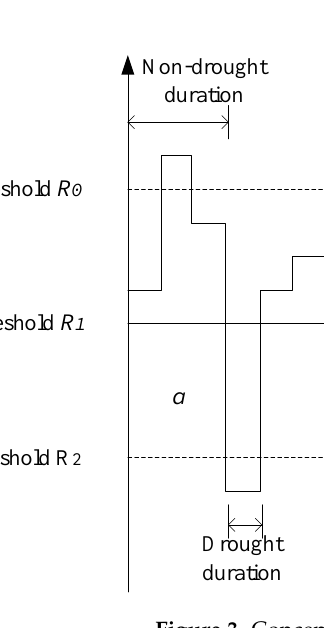
Figure 3. Conceptual diagram of the run analysis theory.